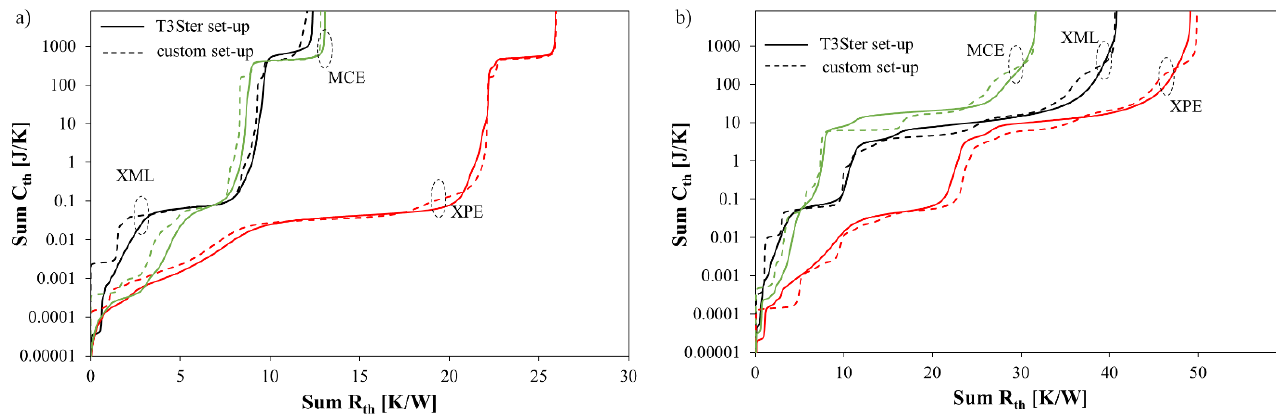
Figure 5. Structure functions of the tested light emitting diodes (LEDs) situated on the heat-sink ( a ) and operating without any heat-sink ( b ). Table 4. Thermal power, optical power, and thermal resistance of the tested power LEDs operat- ing without any heat-sink.